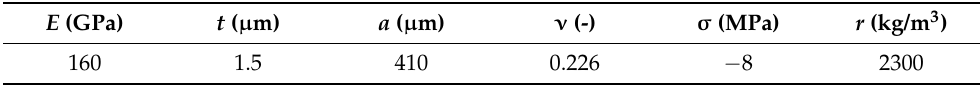
Table 1. Key parameters of the mirror.